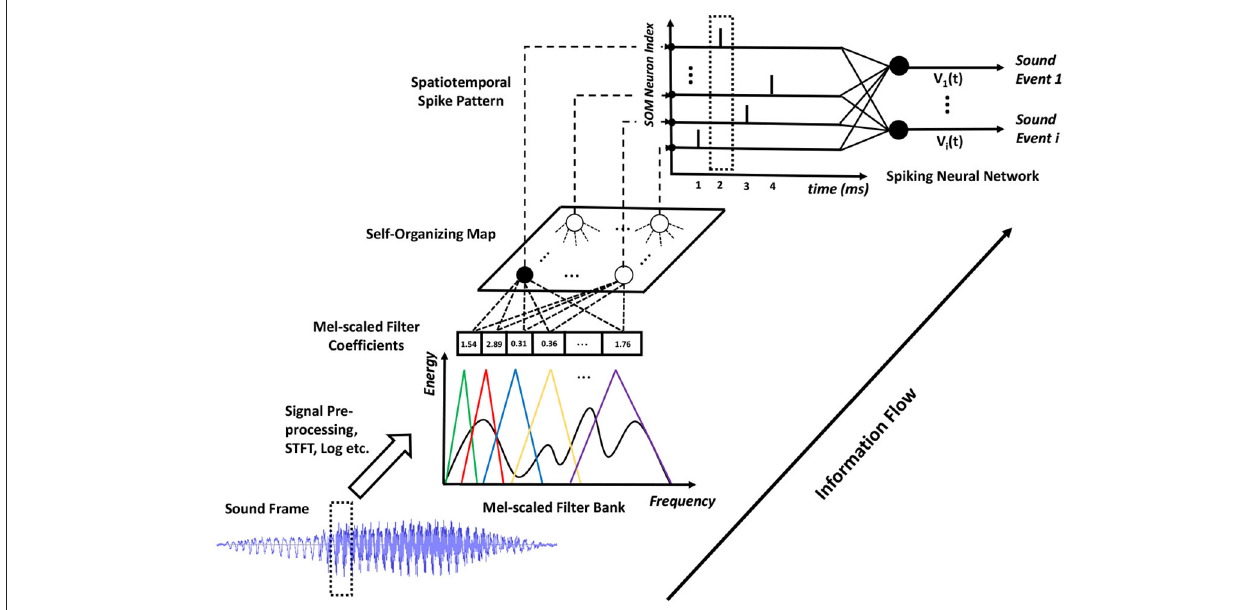
FIGURE 2 | The details of the proposed SOM-SNN ASC framework. The sound frames are pre-processed and analyzed using mel-scaled filter banks. Then, the SOM generates discrete BMU activation sequences which are further converted into spike trains. All such spike trains form a spatiotemporal spike pattern to be classified by the